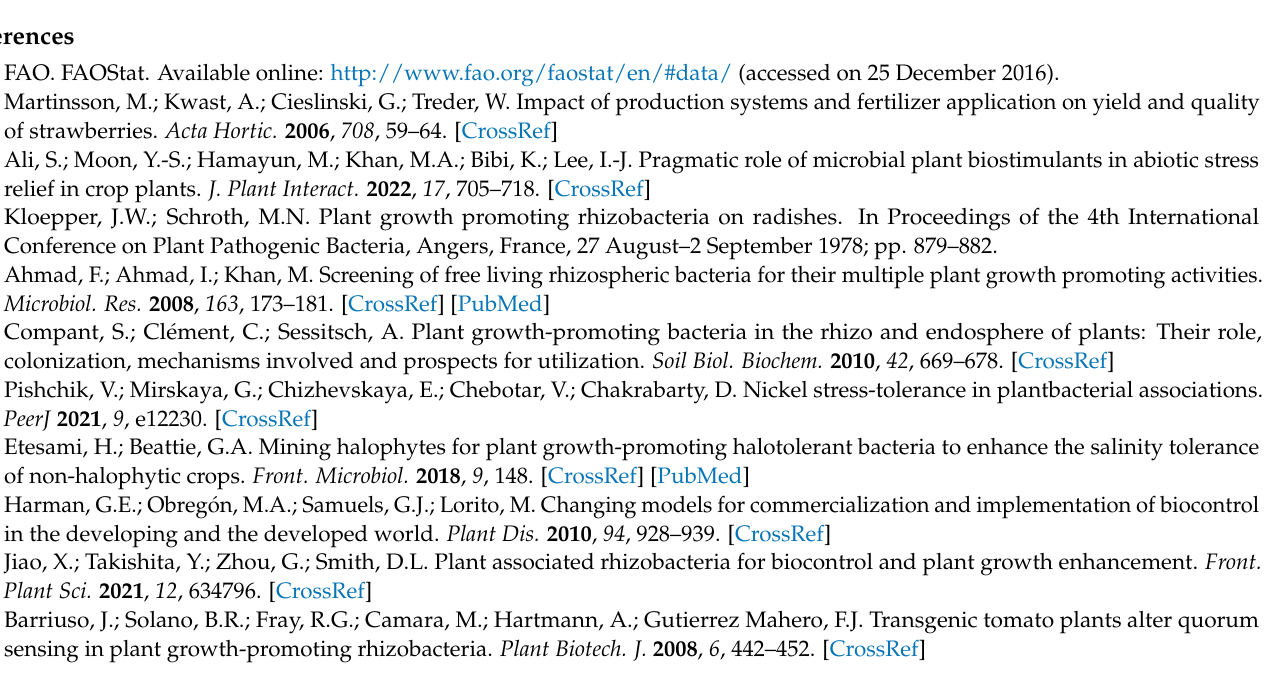
Table S2: The contents of nitrate nitrogen and exchangeable ammonium in the soil in the experiment, mg/kg, 2018–2020. Table S3: Contents of chemical elements in the leaves of strawberries of cv. Rusich in experimental variants (% of 1 g weight of plant leaves). Table S4: Contents of chemical elements in the leaves of strawberries of cv. Troitskaya (% of g weight of plant leaves). Table S5: Chlorophyll content in plant leaves of strawberries of cv. Rusich by year (2018–2020), mg/g of raw mass. Table S6: Chlorophyll content in plant leaves of strawberries of cv. Troitskaya by year (2018–2020), mg/g of raw